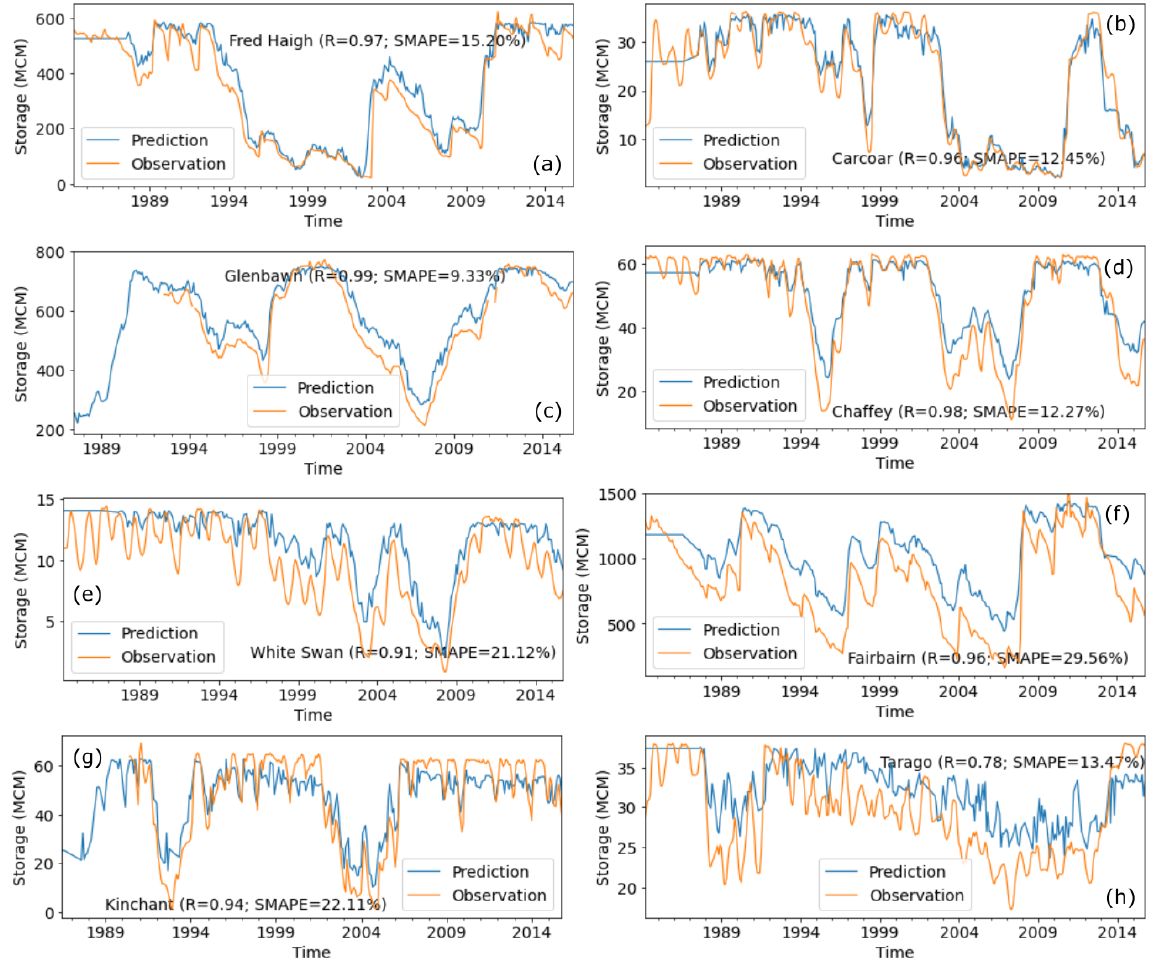
Figure 2. Validation of monthly reservoir storage time series reconstruction against in situ storage data.